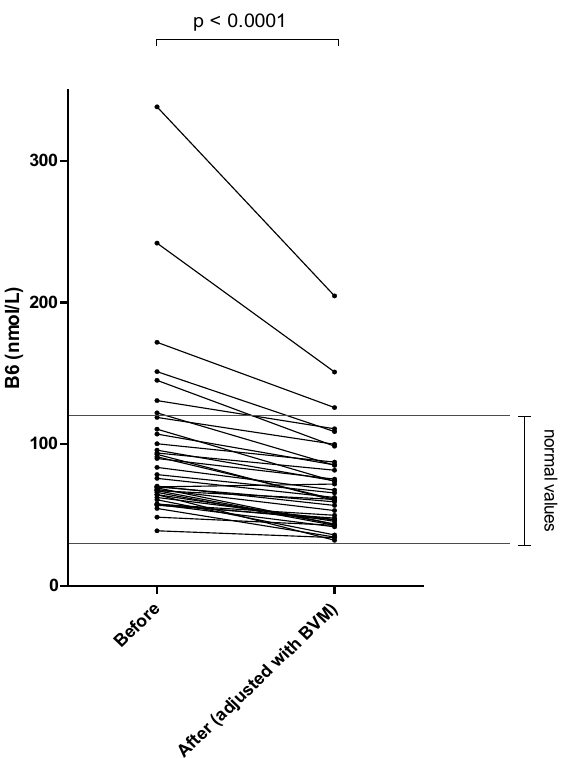
Figure 2. Vitamin B2 (FAD) blood concentration before and after one 4 h-HDF session (paired t- test).